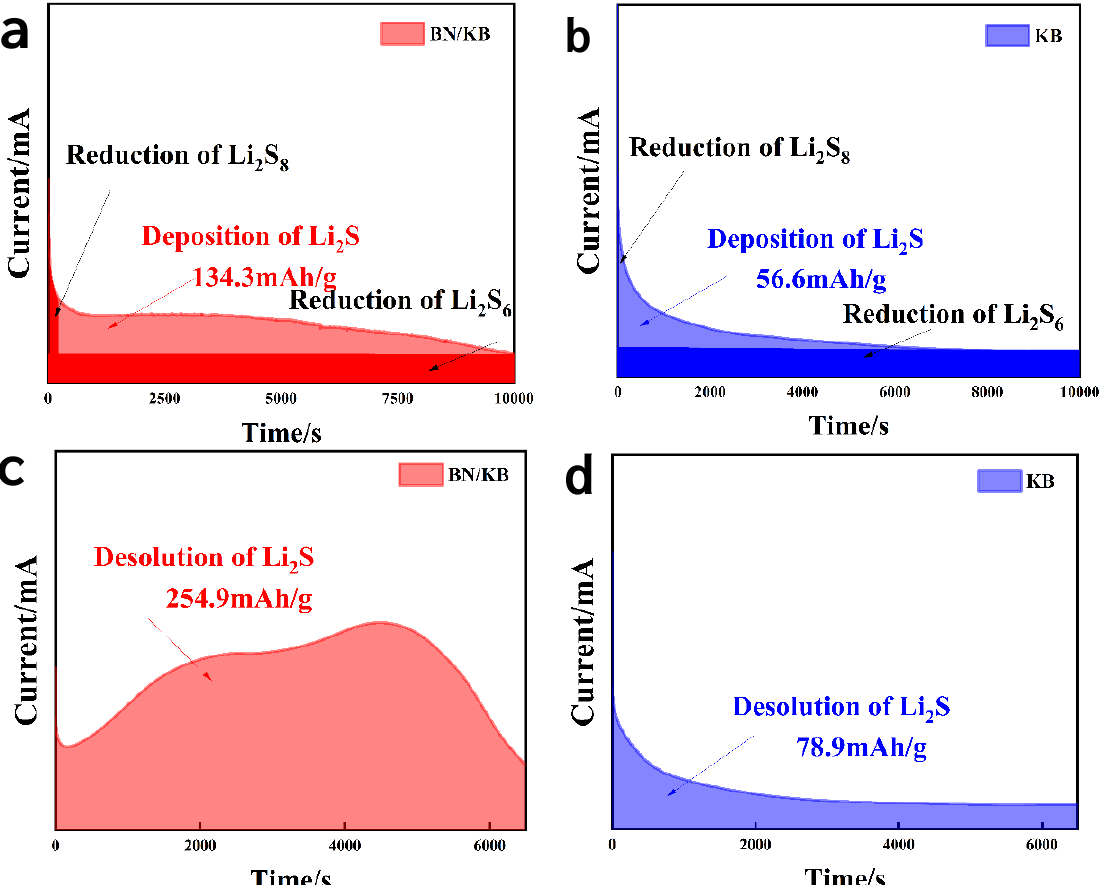
Figure 9. ( a , b ) Potentiostatic discharge profiles at 2.04 V on BN/KB and KB electrodes with Li 2 S 8 catholyte. ( c , d ) Potentiostatic charge profiles at 2.32 V to evaluate the dissolution kinetics of Li 2 S.